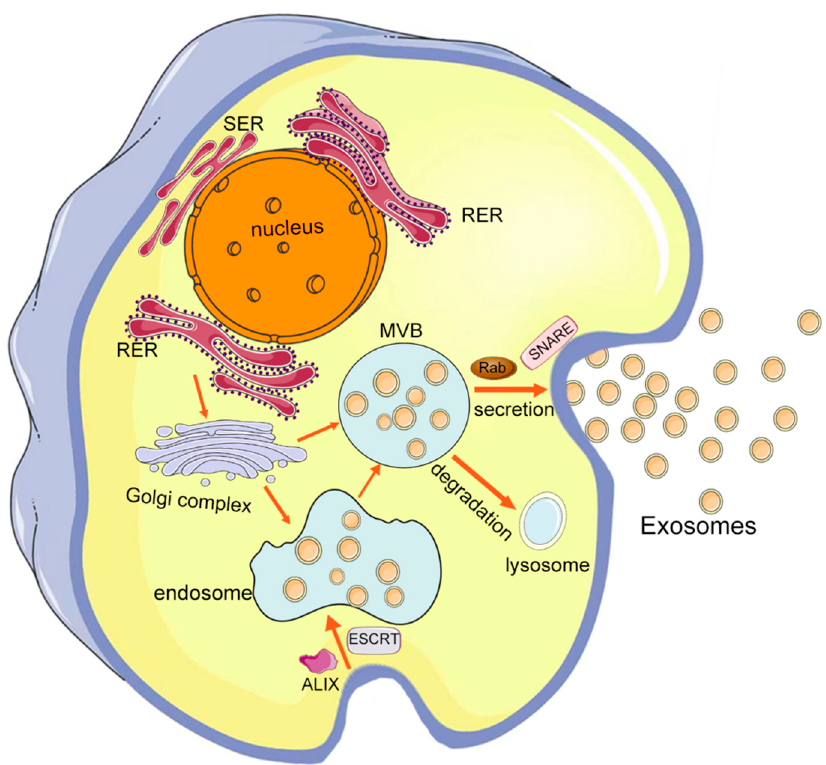
Figure 1. Biogenesis of exosomes. Cells produce small vesicles by endocytosis, which fuse to form endosomes, and are subsequently accompanied by the entry of nucleic acids, proteins, etc. into the endosomes. The endosomes gradually evolve into multivesicular bodies (MVBs), which are subsequently released extracellularly to form exosomes. RER: rough endoplasmic reticulum; SER: smooth endoplasmic reticulum; MVB: multivesicular body; ESCRT: endosomal sorting complex required for transport.